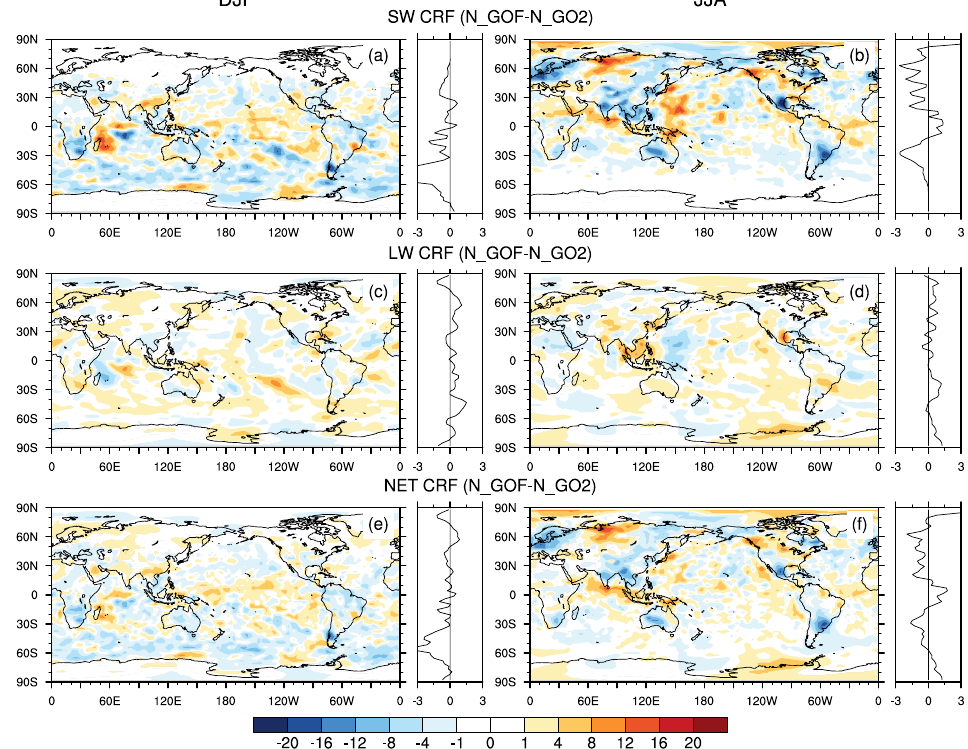
Fig. 9. Differences in (a, b) SW CRF, (c, d) LW CRF, (e, f) net CRF at the TOA between N_GOF and N_GO2, for DJF (left) and JJA